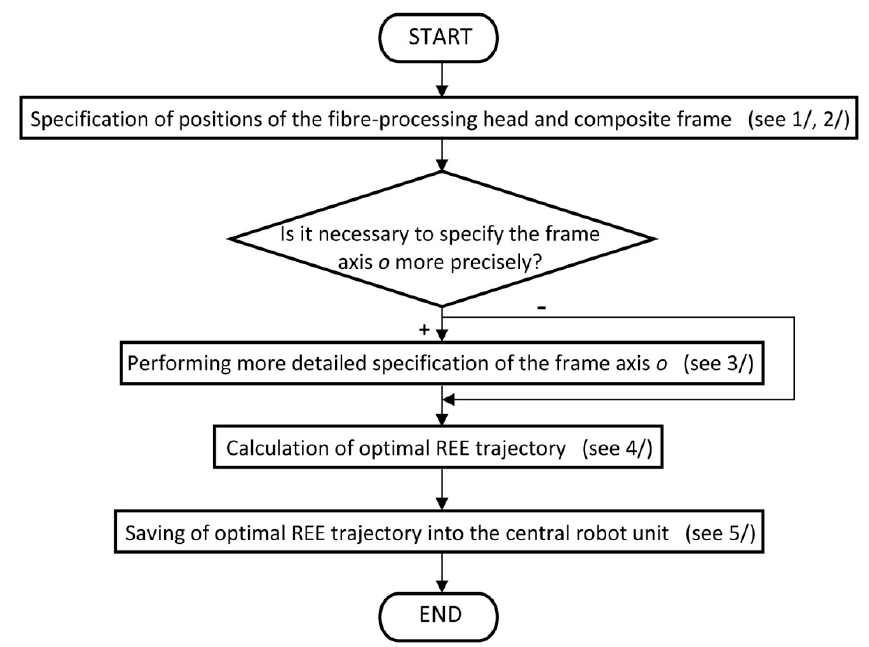
Figure 11. Flowchart of optimal o ff -line REE trajectory calculation.